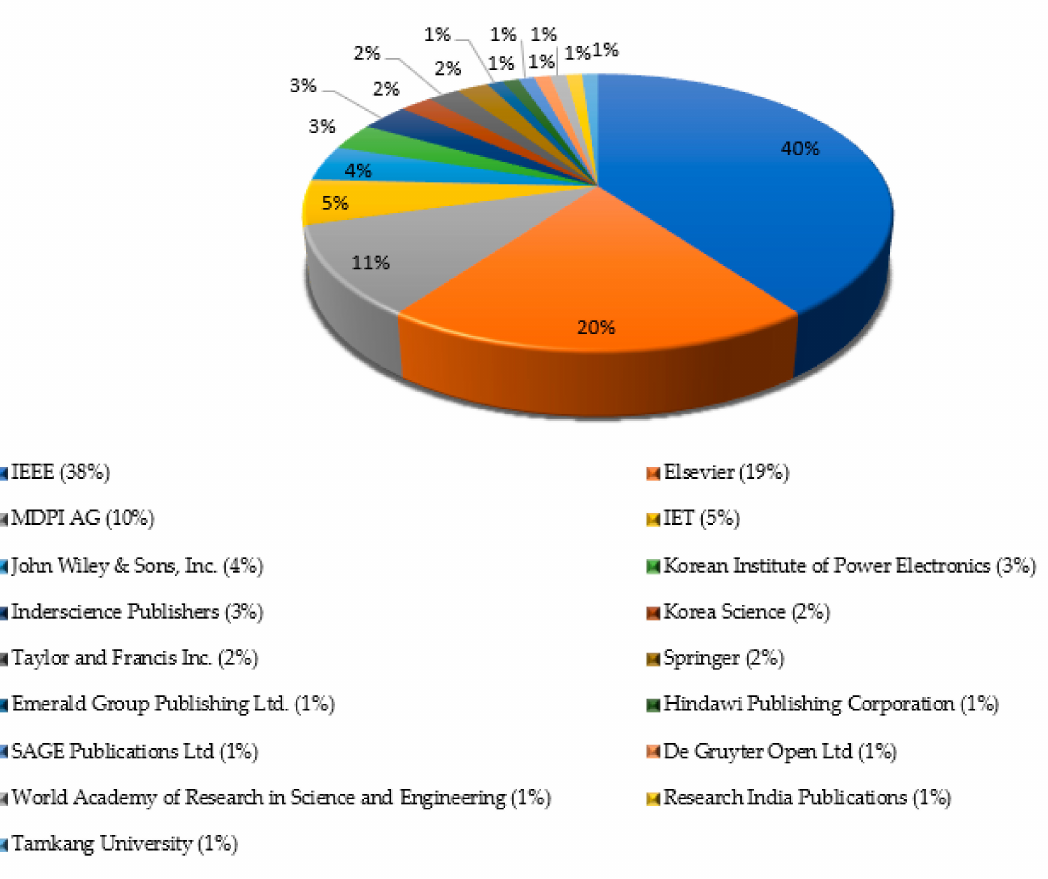
Figure 9. Distribution of 100 manuscripts over the different